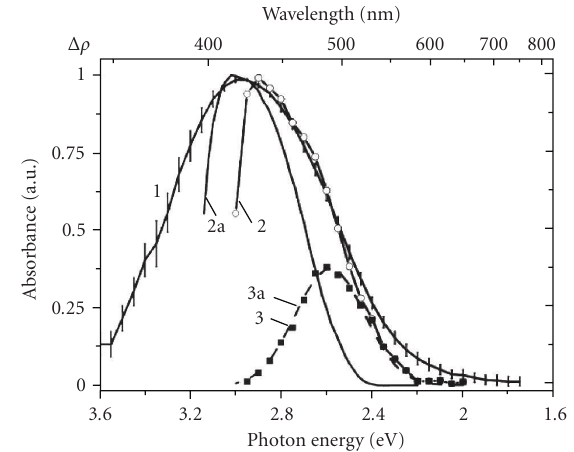
Figure 11: Average absorption spectrum of visible-light-active N- doped TiO 2 specimens (curve 1); di ff erence absorption spectra of N-doped rutile crystal (curve 2) and of the color centers in the yel- low anatase TiO 2 crystal (curve 2a). Curve 3 (solid squares) depicts the di ff erence between curves 2 and 2a; curve 3a (line) is the Gaus- sian fit of curve 3 (see text for more